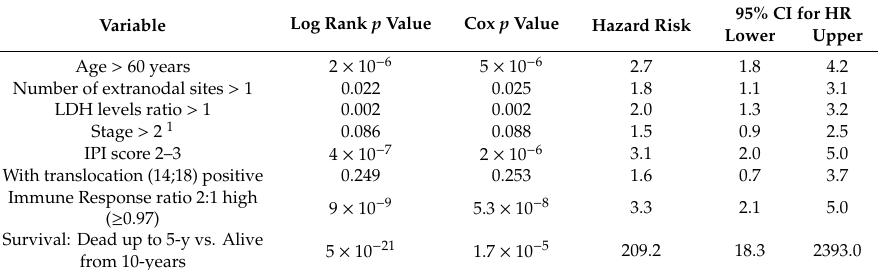
Table 2. Overall survival analysis of the clinicopathological